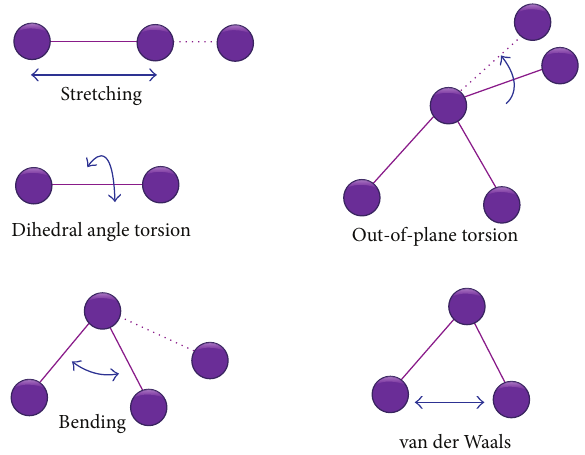
Figure 4: Various bonds between carbon atoms. are considered to be 1.68794 ˚A respectively, and the covalent bond distance of the